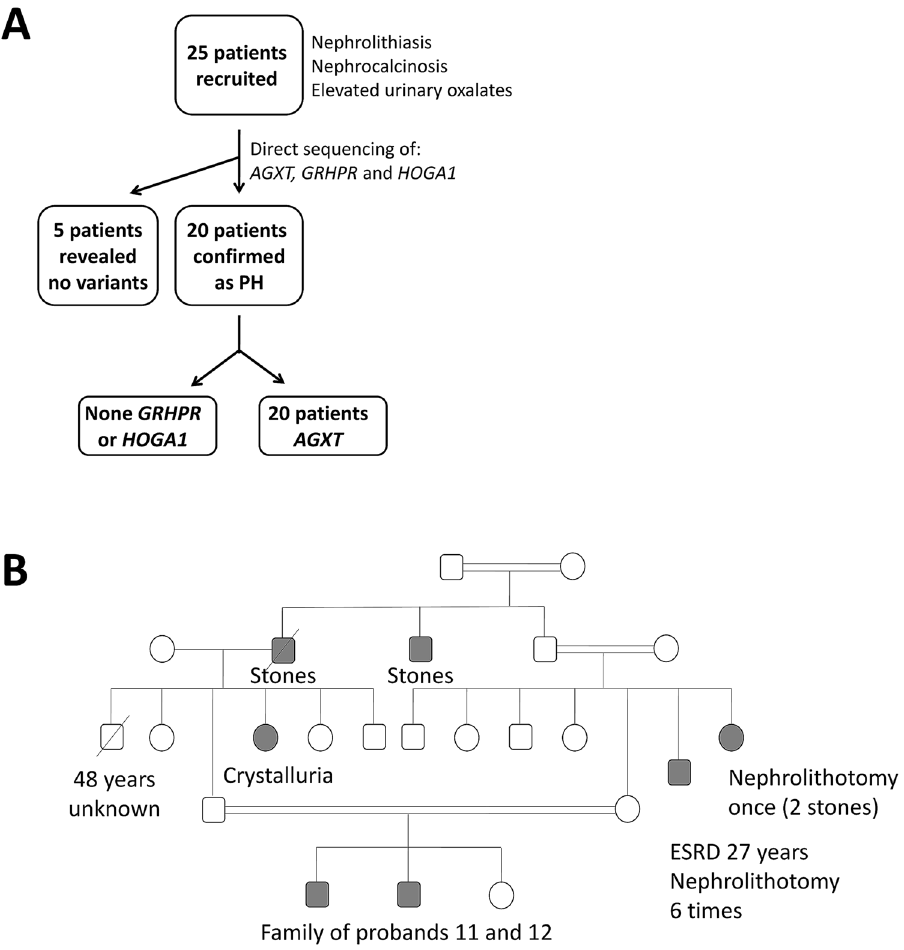
Figure 1. ( A ) A flowchart of patients recruited in the study. ( B ) A pedigree with multiple affected cases in the same